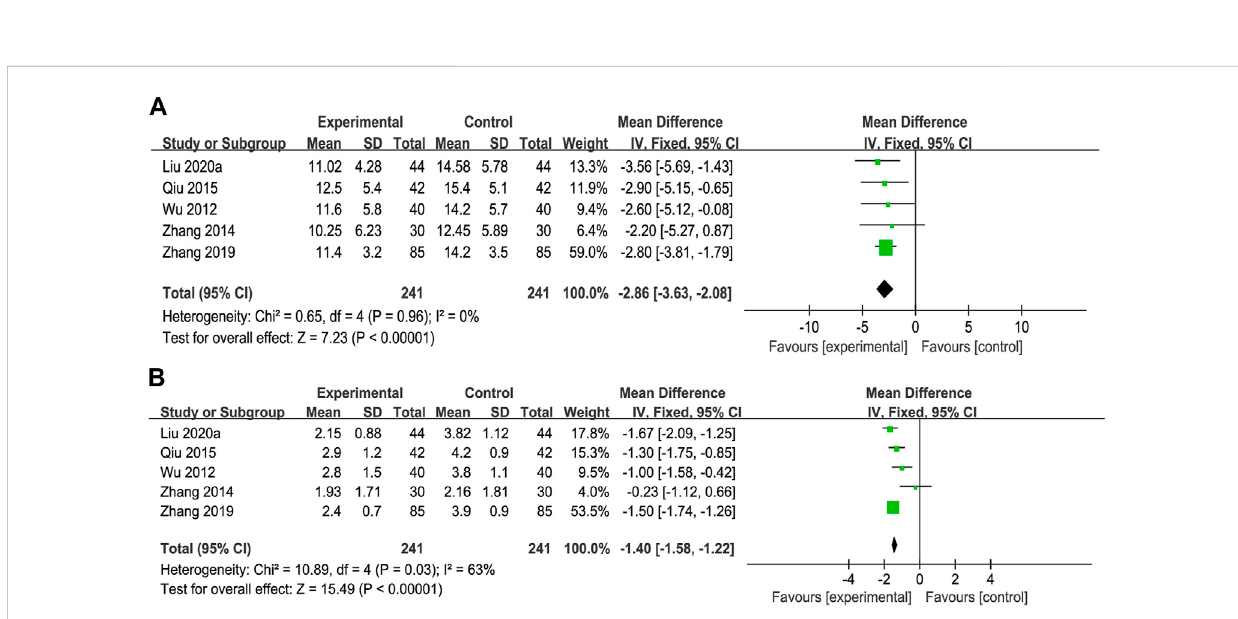
FIGURE 7 Forest plot of meta-analysis of immune function (A) immunoglobulin G (IgG); and (B) immunoglobulin M (IgM).